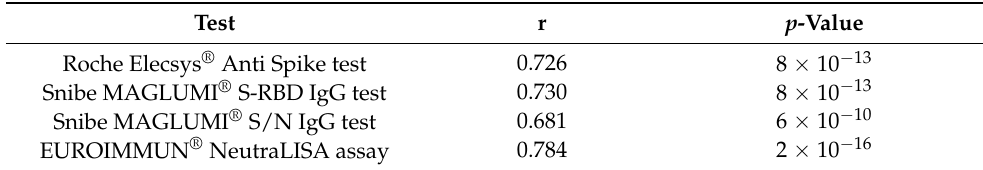
Table 3. Spearman’s rank correlation coefficients (r) relevant to PRNT 50 results and each of the studied serological assays.